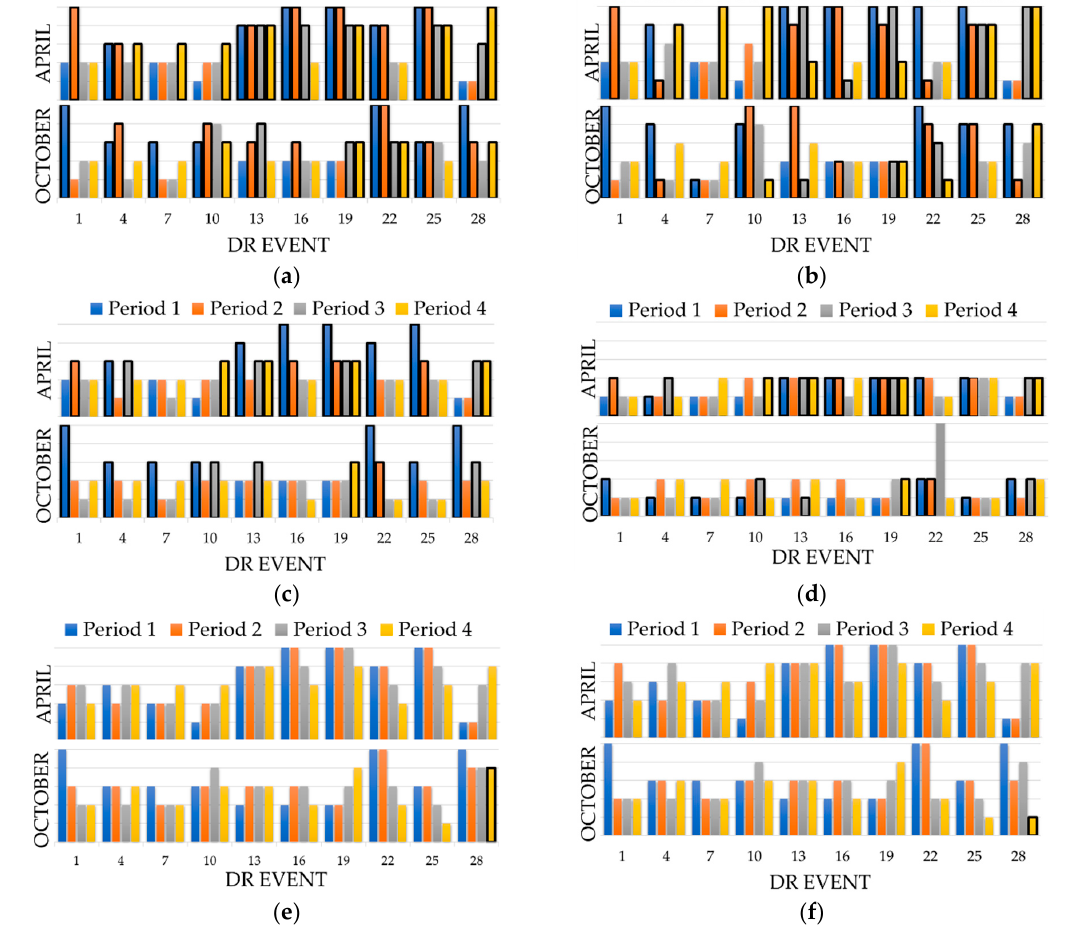
Figure 11. Season comparison for Consumer 41: April vs. October. ( a ) Method 1—initial rate; ( b ) Method 1—final rate; ( c ) Method 2—initial rate; ( d ) Method 2—final rate; ( e ) Method 3—initial rate; ( f ) Method 3—final rate.